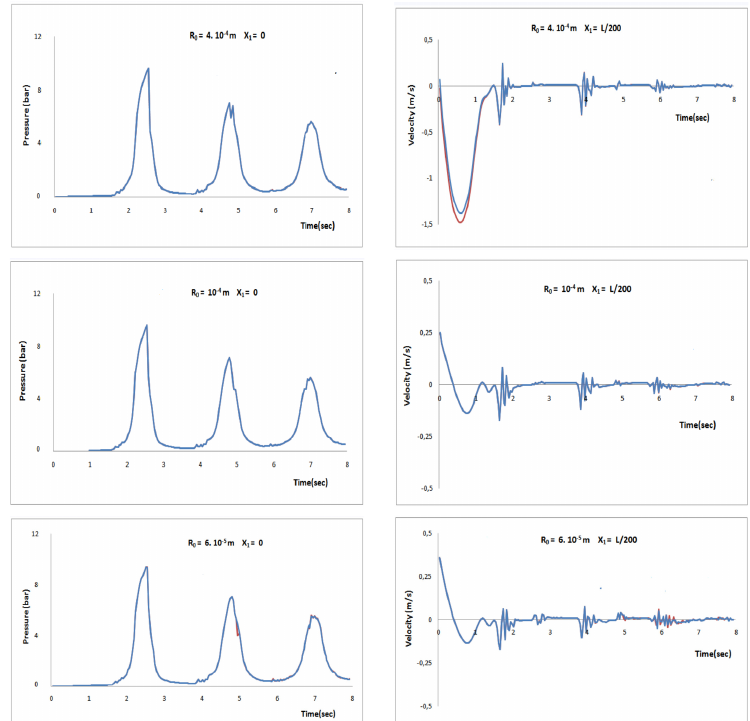
Figure 2. Comparison between the numerical schemes (4.2) and (4.3) for CO2/Water mixture with dissolved gas concentration